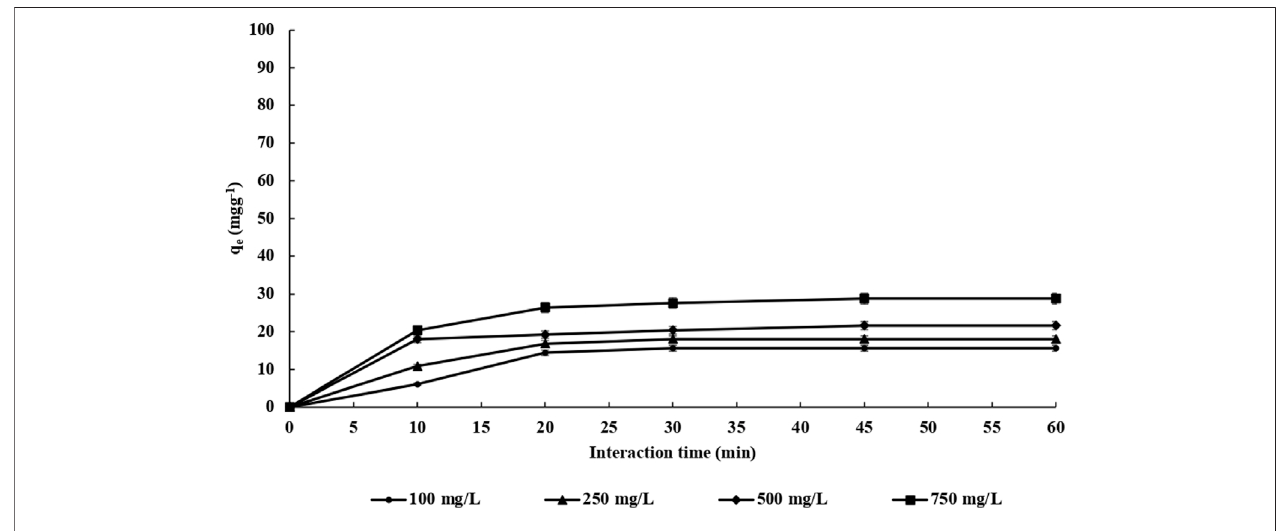
FIGURE 7 | The effect of interaction time on the adsorption capacity of DE-APTES.